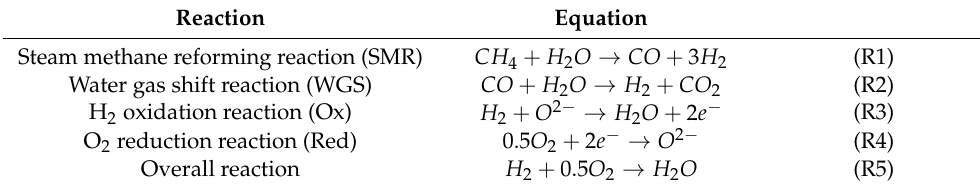
Table 3. Reactions considered inside a